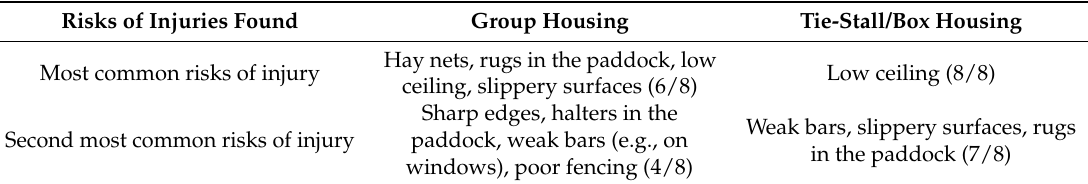
Table 3. Safety risks observed and photographed on visits to the riding schools. Statistical comparisons between housing methods were not made. There were slippery surfaces both outdoors and indoors. ‘Low ceiling’ in this case includes low parts of the box